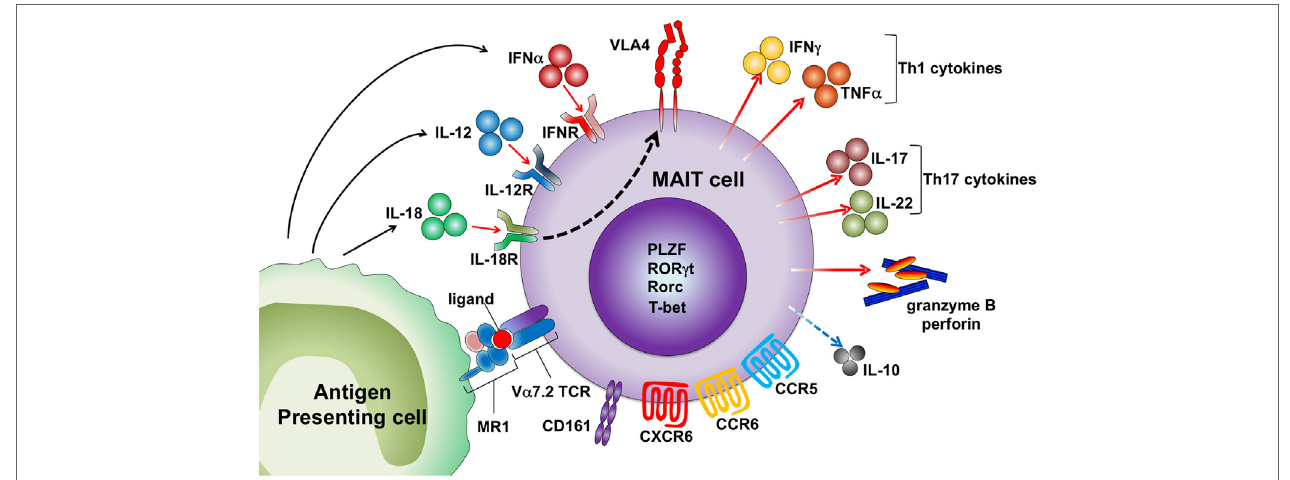
FigURe 1 | Activation mechanisms of human mucosal-associated invariant T (MAIT) cells. MAIT cells are activated by the MR1 ligand derived from microbes and drugs. Cytokines, including IL-12, IL-18, and IFN α , also activate MAIT cells by an antigen-independent mechanism. MAIT cells express several chemokine and cytokine receptors and homing receptors. Activated MAIT cells upregulate very late antigen-4 (VLA-4) and secrete granzyme B and perforin, Th1/Th17 cytokines, and low levels of